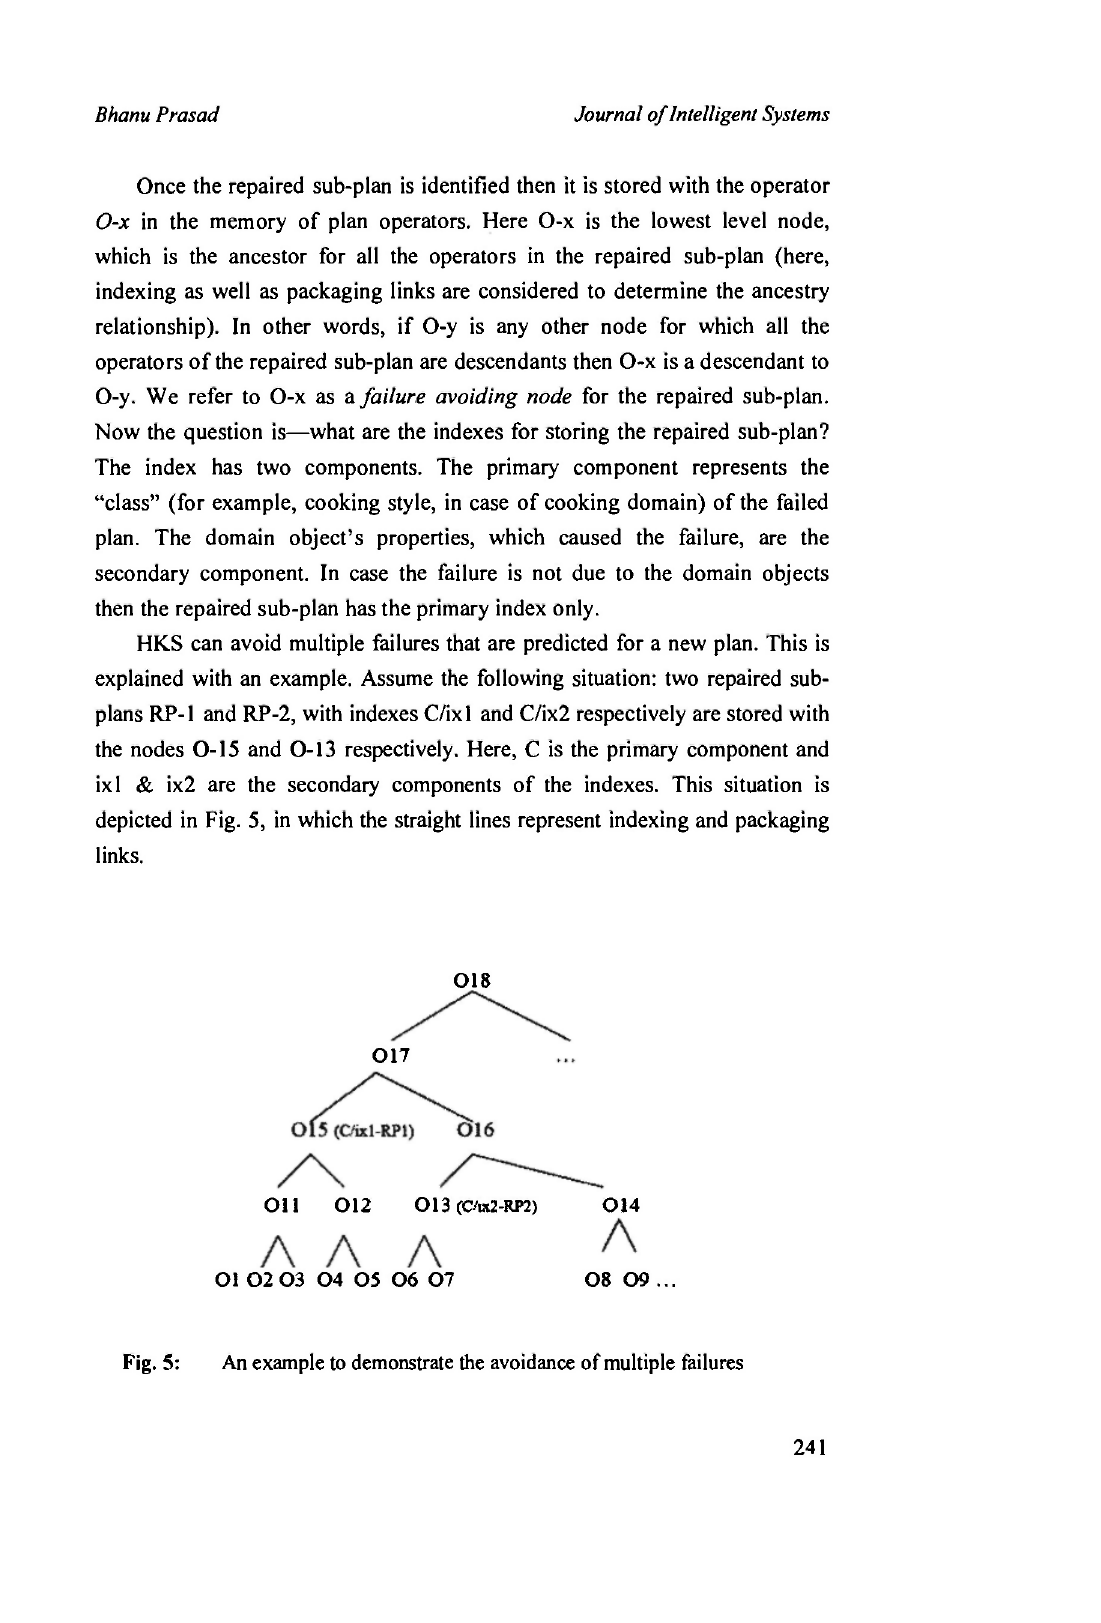
An example to demonstrate the avoidance of multiple